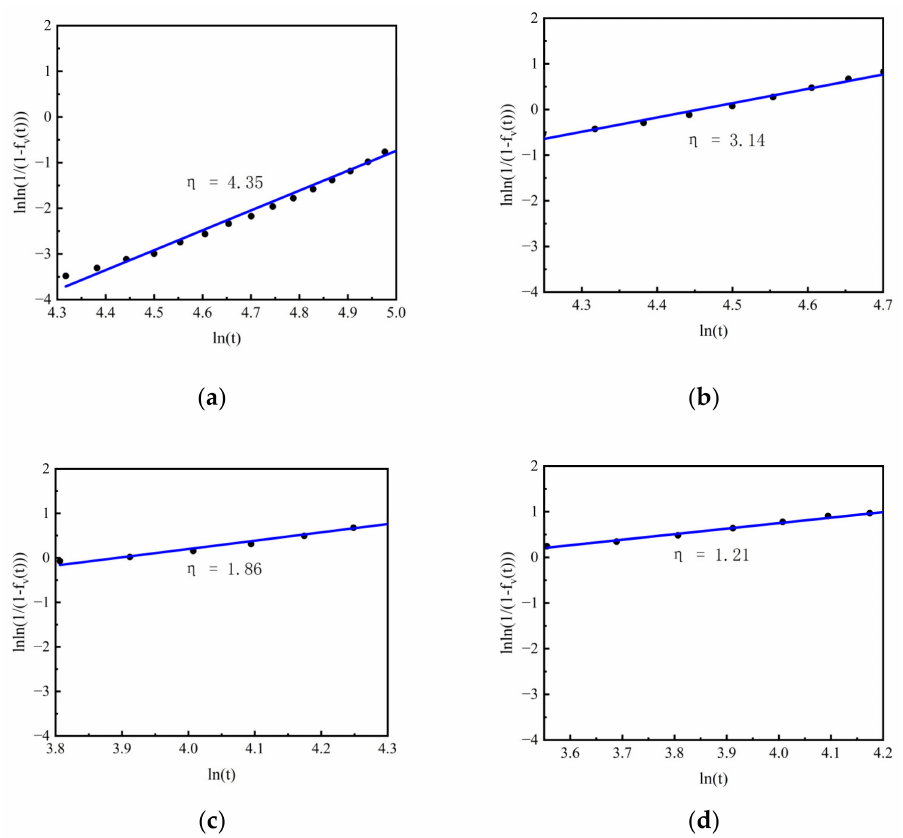
Figure 10. Avrami plot (time evolution of the solid fraction f V ( t ) plotted as the relation of lnln ( 1/ ( 1 − f v ( t ))) vs. ln ( t ) ) during the isothermal-solidification process at ( a ) 0 MPa, ( b ) 100 MPa, ( c ) 200 MPa, and ( d ) 300 MPa,